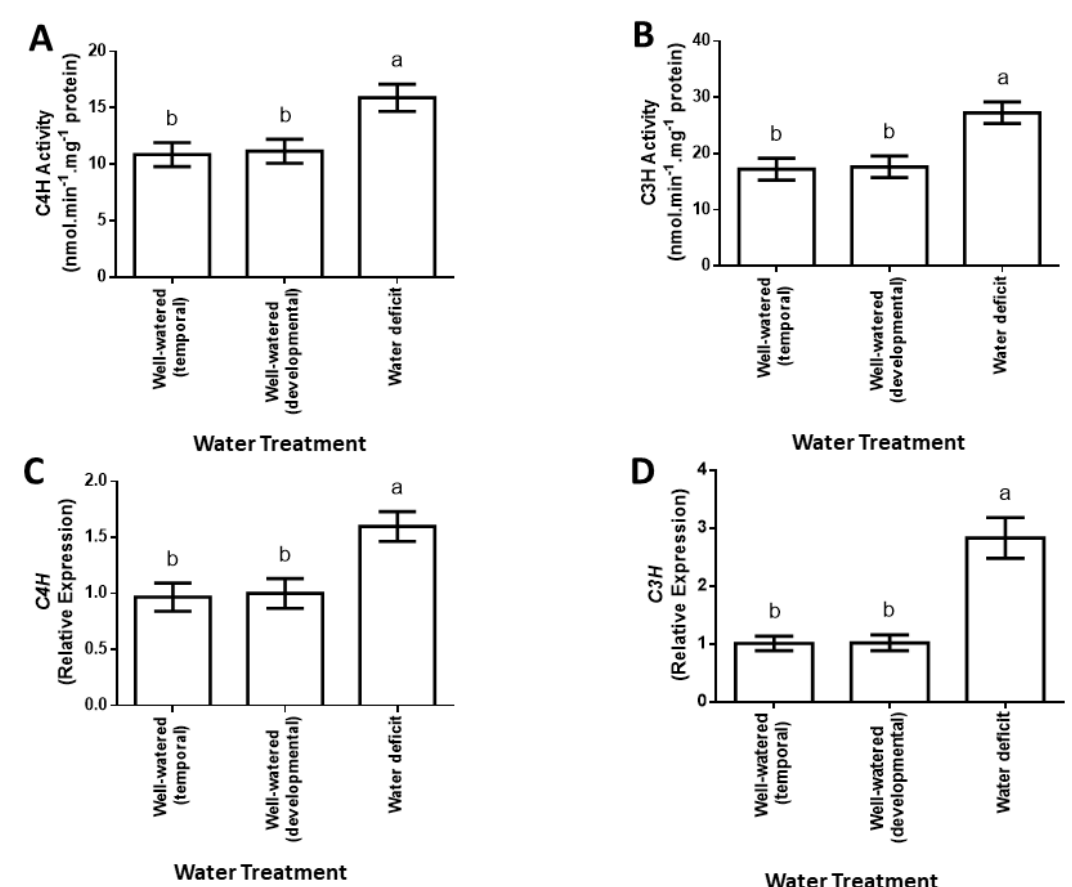
Figure 3. Changes in the enzymatic activities of C4H ( A ) and C3H ( B ) in relation to effects of water deficit on the expression of genes encoding a cinnamate 4 − hydroxylase ( C ) and a p − coumarate 3 − hydroxylase ( D ) in maize leaves. Data represent means of three independent experiments in tissue obtained from the third youngest leaf of each treatment. C4H is cinnamate 4 − hydroxylase and C3H is p − coumarate 3 − hydroxylase. Error bars with different letters represent significantly different means ± SD at a confidence level defined by p ≤ 0.05.